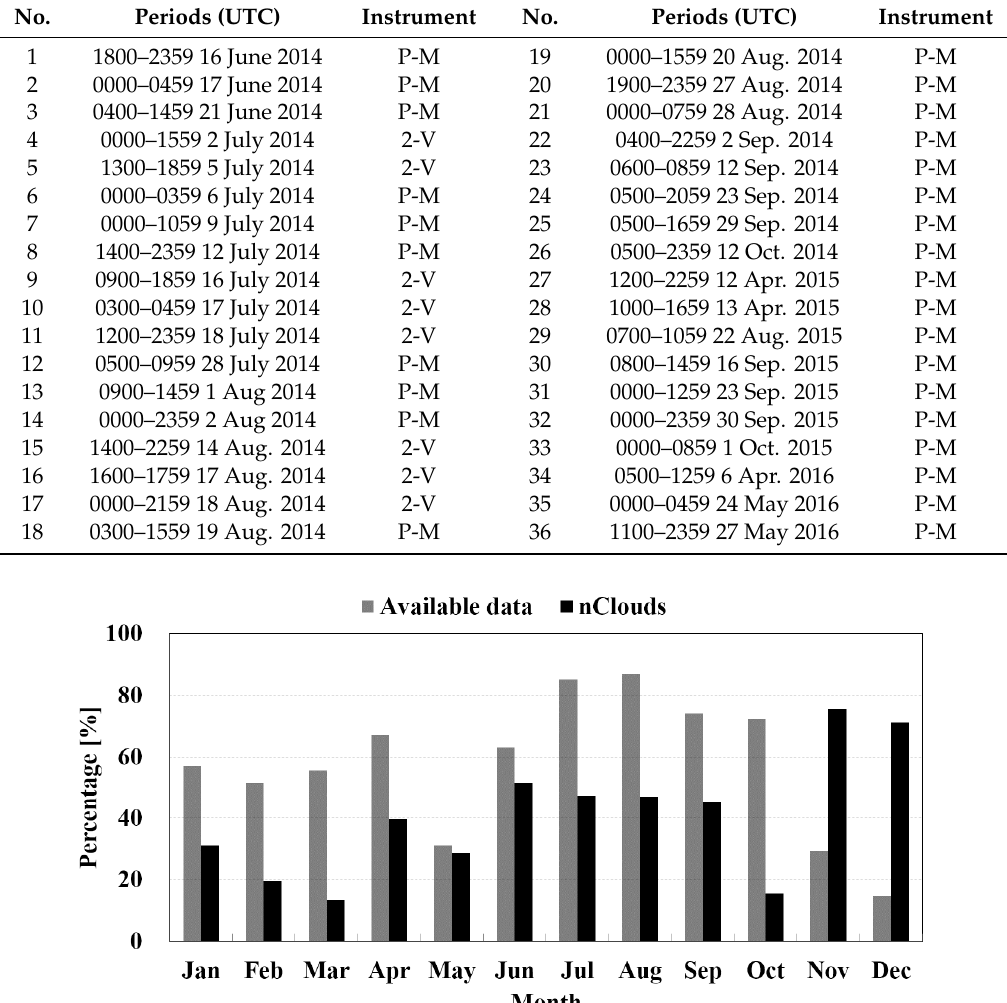
Table 2. 36 rain events used to derive the calibration biases of the cloud radar reflectivity. The P–M and 2–V indicate the pairs of the particle size and velocity (PARSIVEL) and the micro rain radar (MRR), and the two-dimensional video disdrometer (2DVD) and the vertically pointing X-band radar (VertiX), respectively.